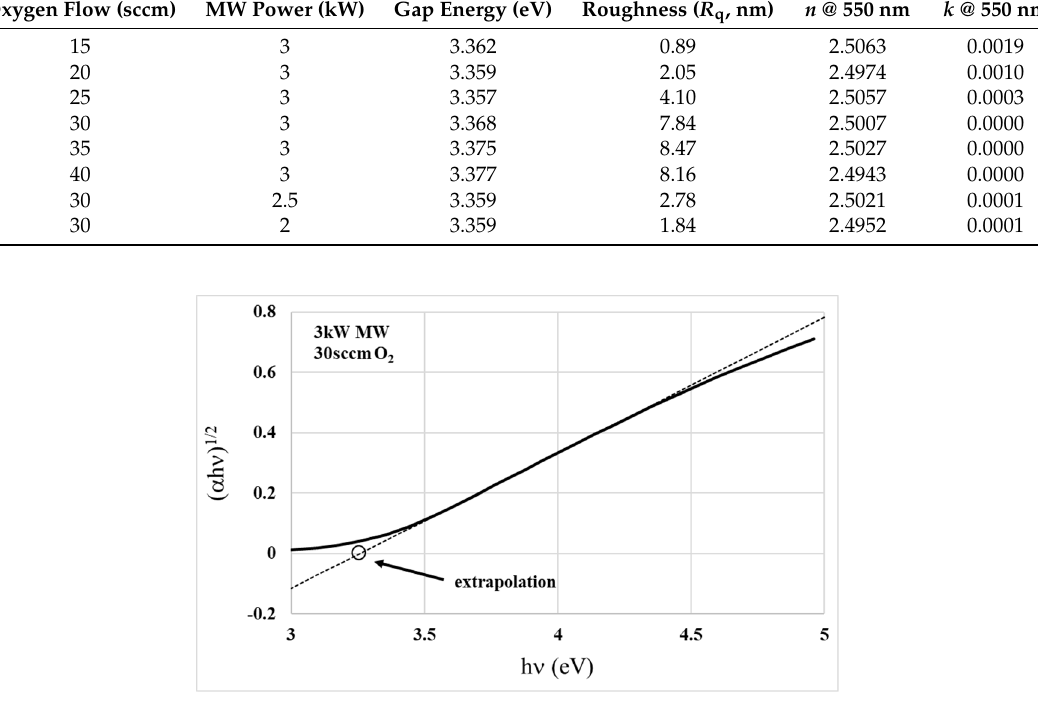
Figure 8. Example of one of the extrapolation fitting for obtaining gap energy using Tauc Plot. Table 4. List of gap energies extracted using Tauc plot.